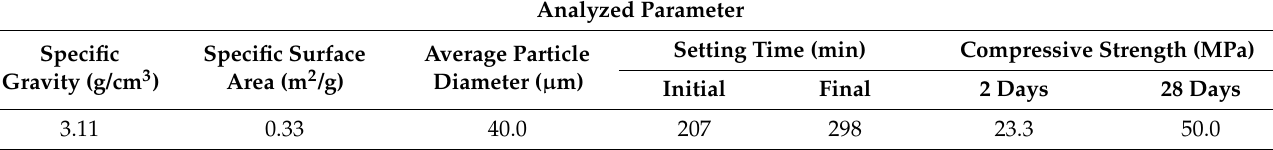
Table 2. Physical properties of OPC.